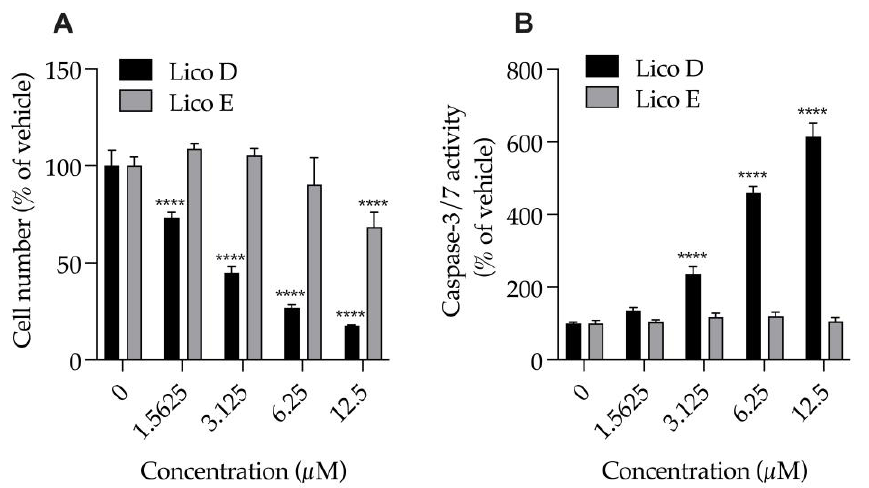
Figure 3. Effect of Licos D and E on the number of cells and caspase-3/7 activity of SIM-A9 cells. ( A ) The number of viable cells was determined after each separate treatment with Licos D and E (1.5625, 3.125, 6.25 and 12.5 µ M) for 24 h. Cell number was calculated using 100% viable cells in the vehicle control group. ( B ) Caspase-3/7 activity was presented as a percentage of vehicle control. Values are the mean ± SD ( n = 4). **** p < 0.0001 compared with vehicle control. Statistical analysis of the data was performed using Tukey’s multiple comparisons test .